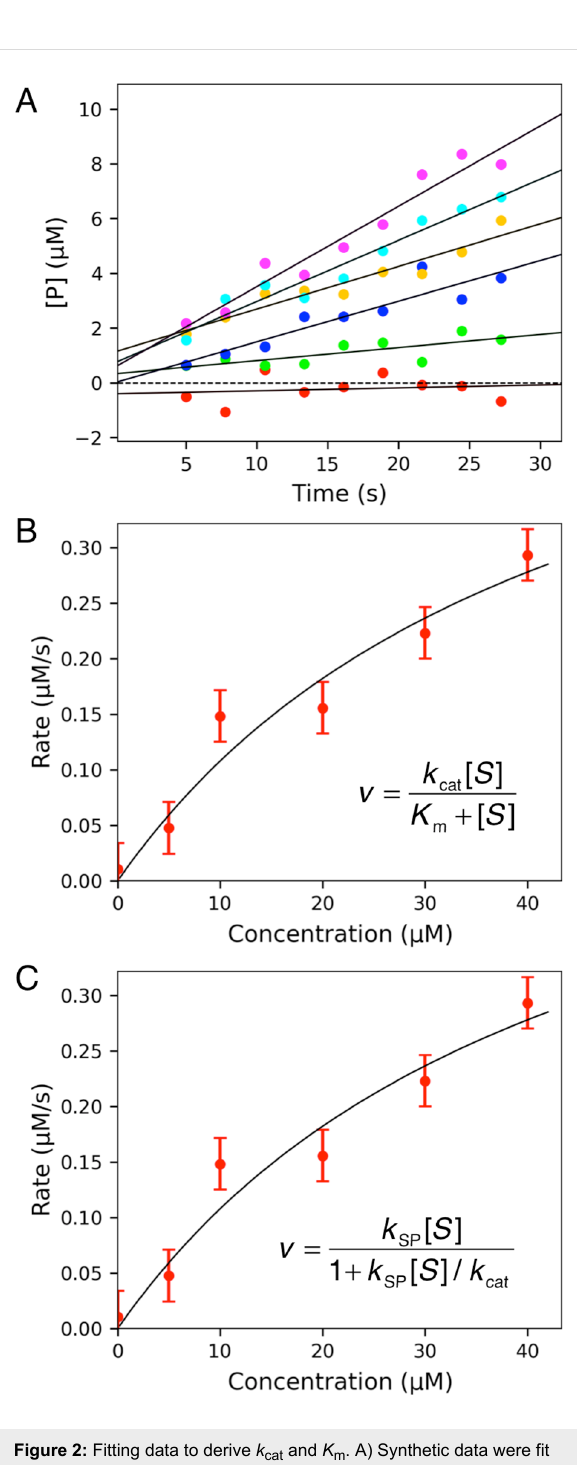
Figure 2: Fitting data to derive k cat and K m . A) Synthetic data were fit to a straight line and then the observed rate was plotted versus sub- strate concentration (B, C). In B), the data were fit to standard Michaelis–Menten equation while in C), the data were fit to a modified form equation. The equations used are shown in each